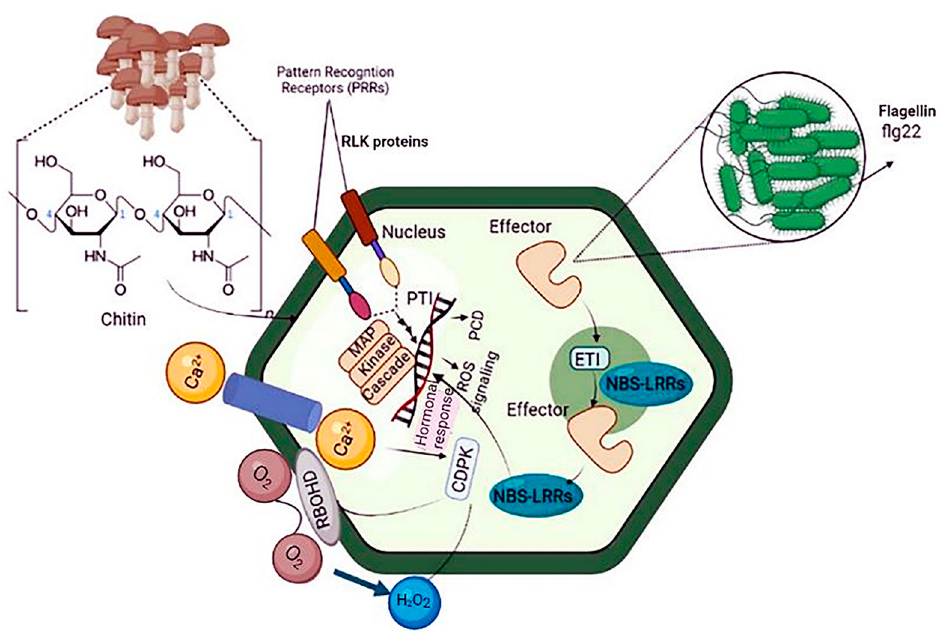
Figure 1. Schematic diagram of plant immunity against bacterial pathogens. Plants use two strategies to respond to pathogen attacks: PTI and ETI. Because ETI recognizes specific proteins injected by the pathogen rather than PAMPs, ubiquitous molecules expressed by all microorganisms, it is more pathogen strain-specific than PTI. The plant must express a resistance protein that recognizes a specific factor protein for ETI to occur. PTI: pattern-triggered immunity, ETI: effector-triggered immunity, and PAMP: pathogen-associated molecular patterns.